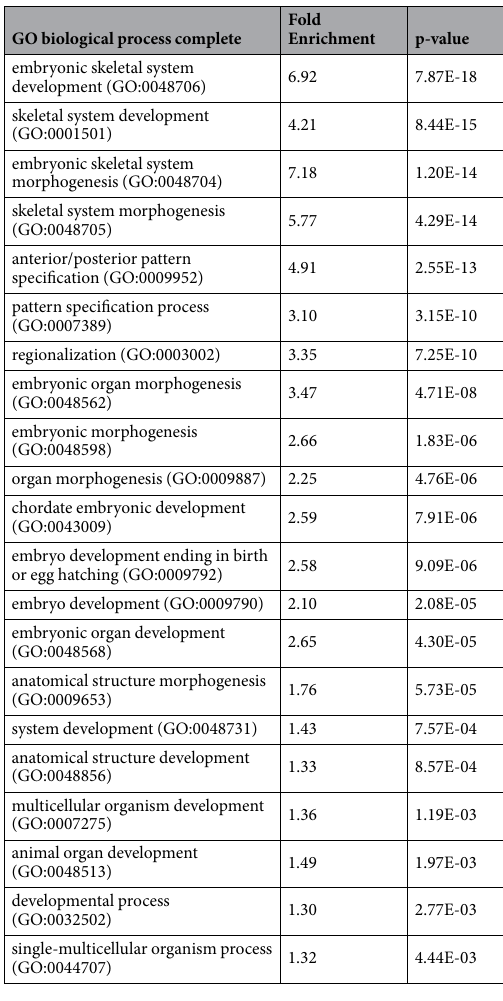
Table 1. Gene Ontology analysis of the genes belonging to the two homeobox families of size 25 and 34. Only results with p-value below 0.01 are shown. The enriched annotations are mainly associated to development and morphogenesis of multicellular